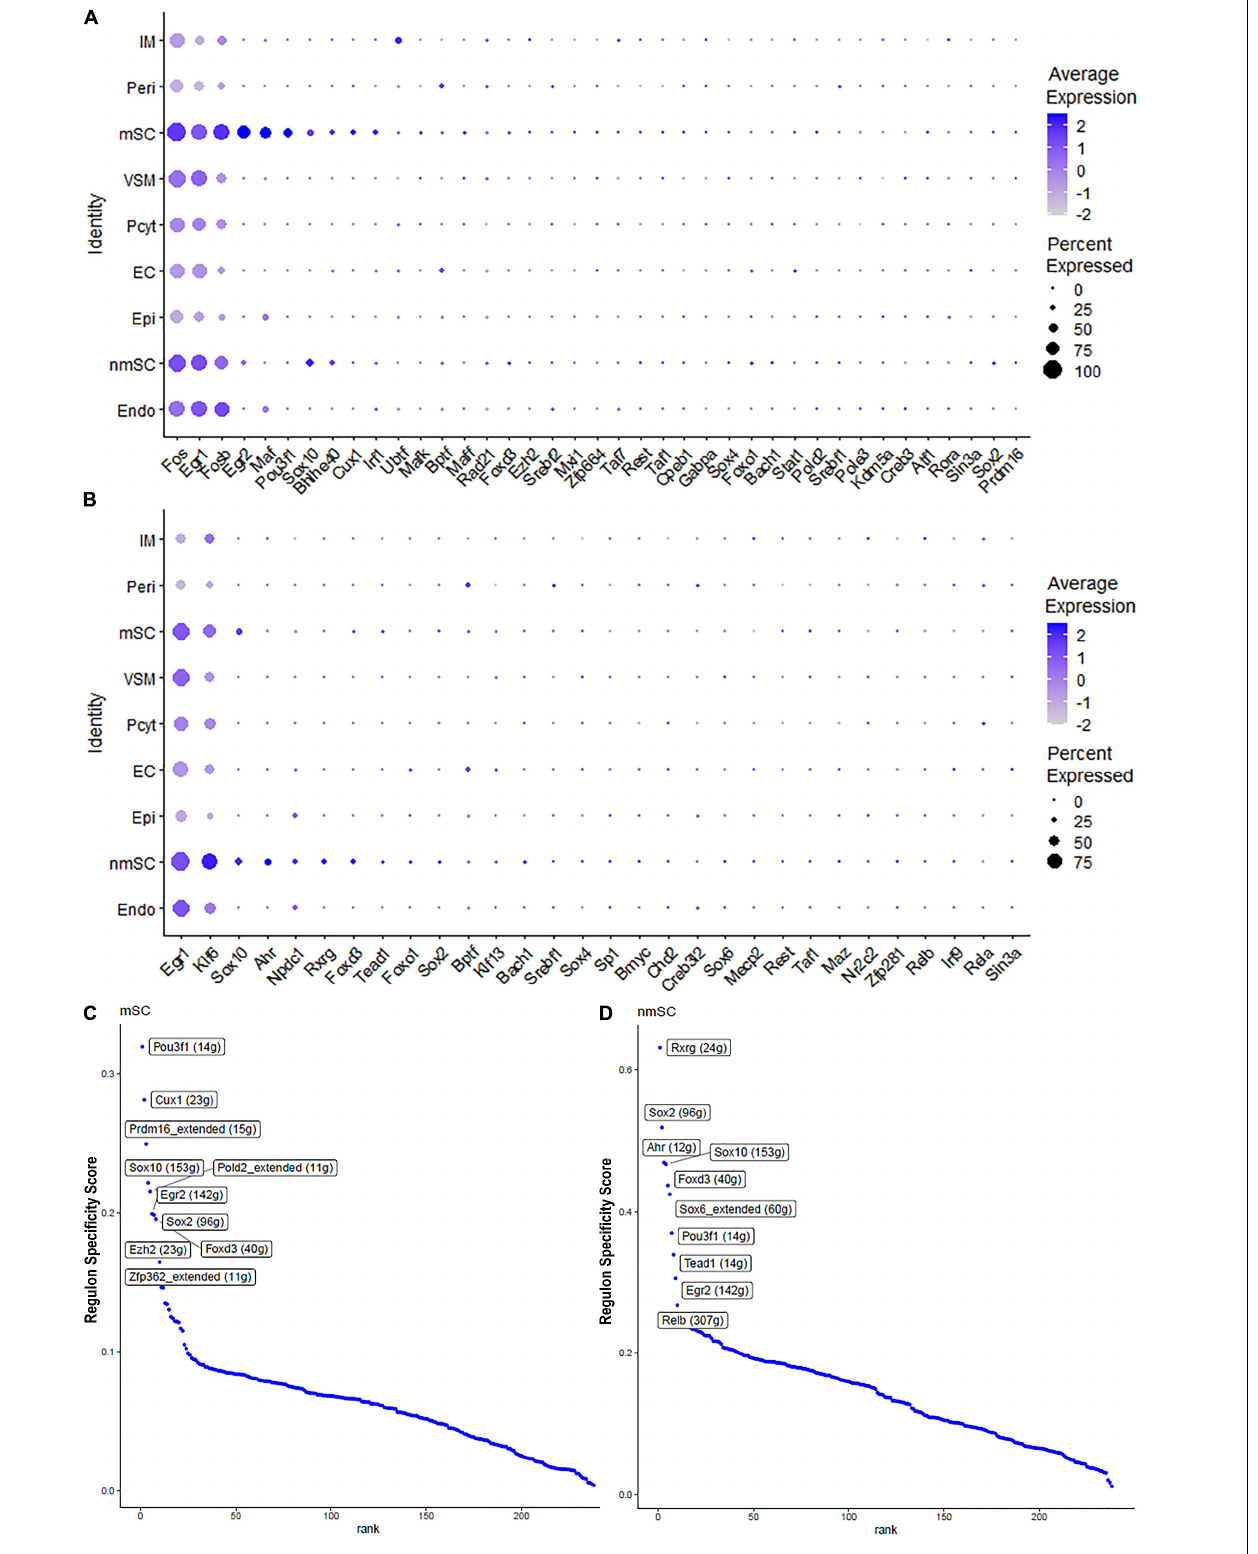
FIGURE 3 | TF expression in mSCs and nmSCs. (A) Thirty-nine identified TFs in mSCs showing more than 5% of mSC expression. (B) Thirty identified TFs in nmSC showing more than 5% of nmSC expression. (C) Top 10 transcription activities in mSCs. (D) Regulon-specificity score in nmSCs with top 10 specific TFs labeled.